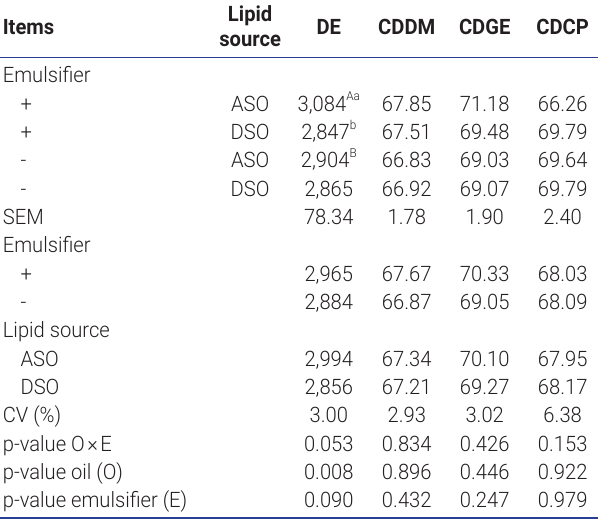
Table 9. Average values of digestible energy (kcal/kg) and